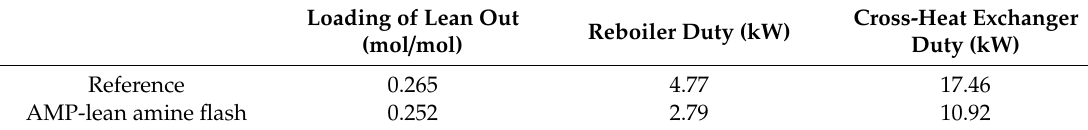
Table 4. Results for lean amine flash configuration.